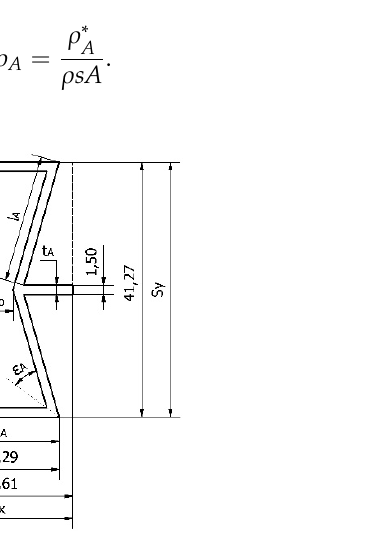
Figure 4. An elementary cut of the auxetic core structure (dimensions in mm).